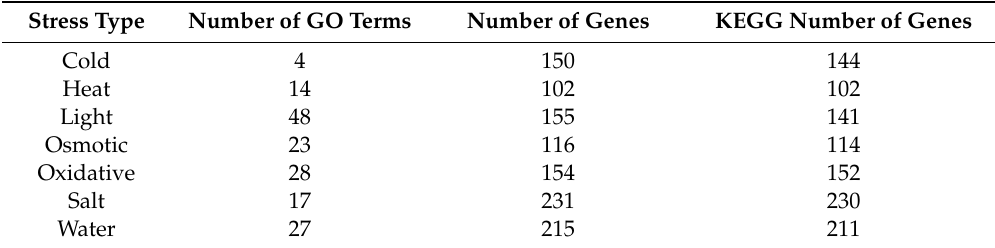
Table 1. Number of GO terms and genes that have identified associations with studied stress types.